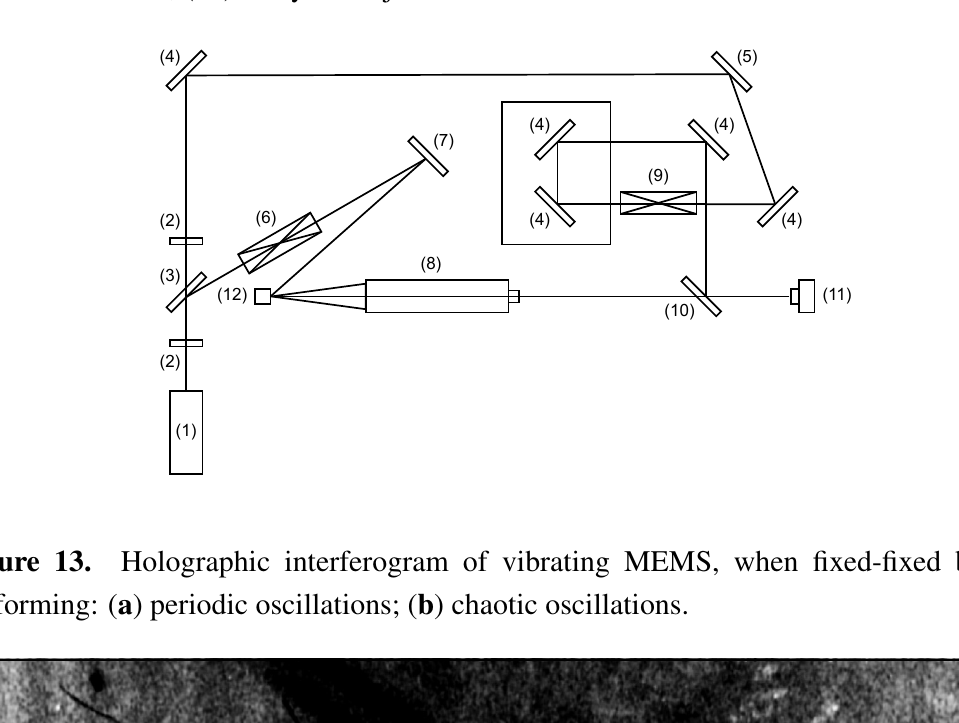
Figure 12. Schematic diagram of the microscopic holographic system: (1) He-Ne laser;